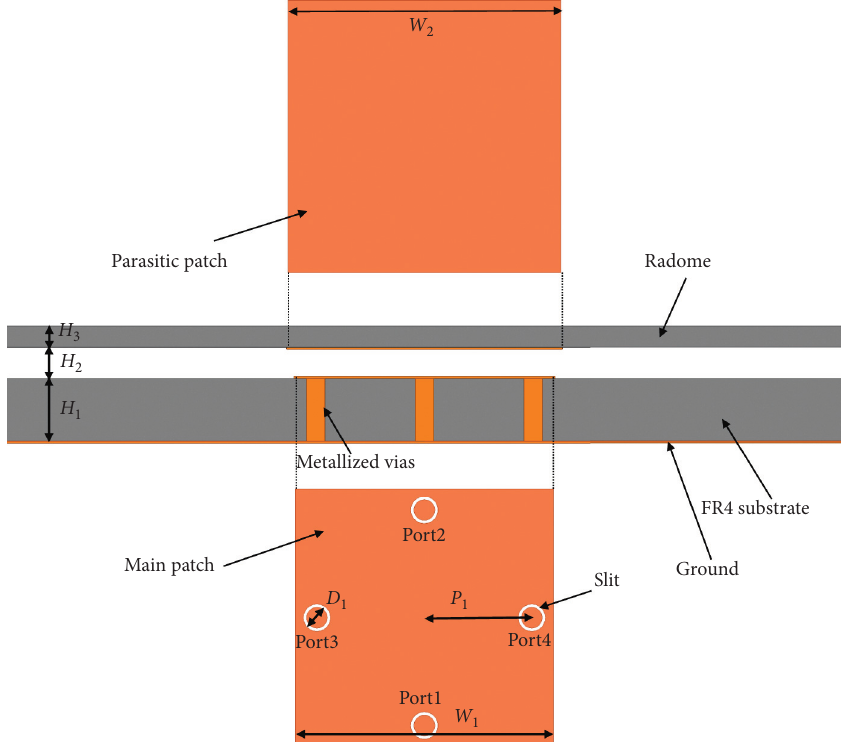
Figure 1: Configuration of the antenna element.